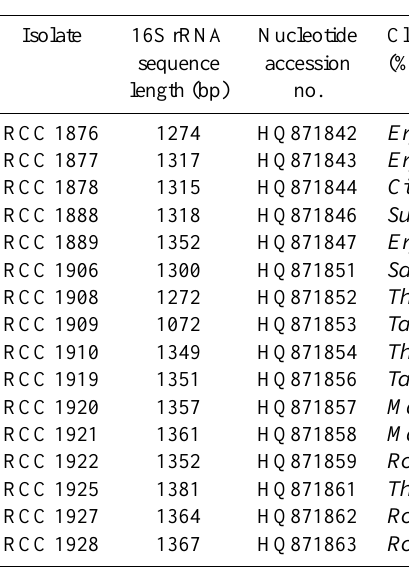
Table 2. Closest phylogenetic neighbor, nucleotide accession number and 16S rRNA gene sequence length of the AAP bacteria isolated from the Mediterranean